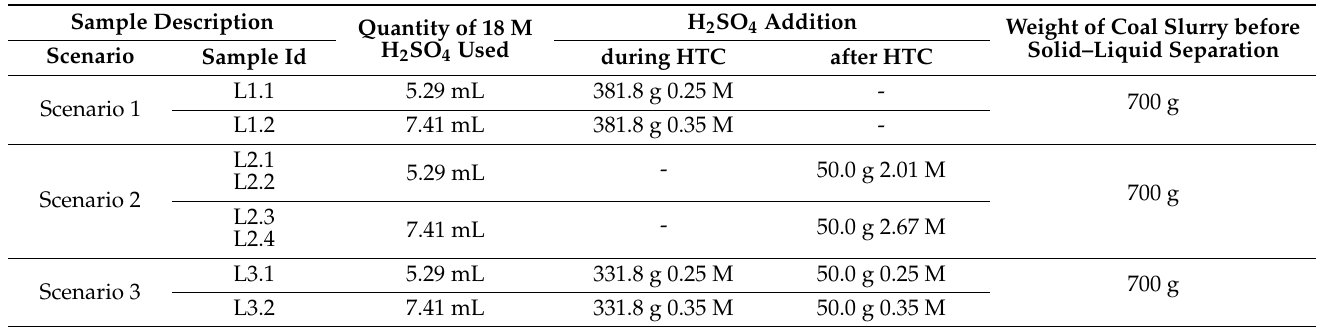
Table 1. Utilization of H 2 SO 4 during the experimental